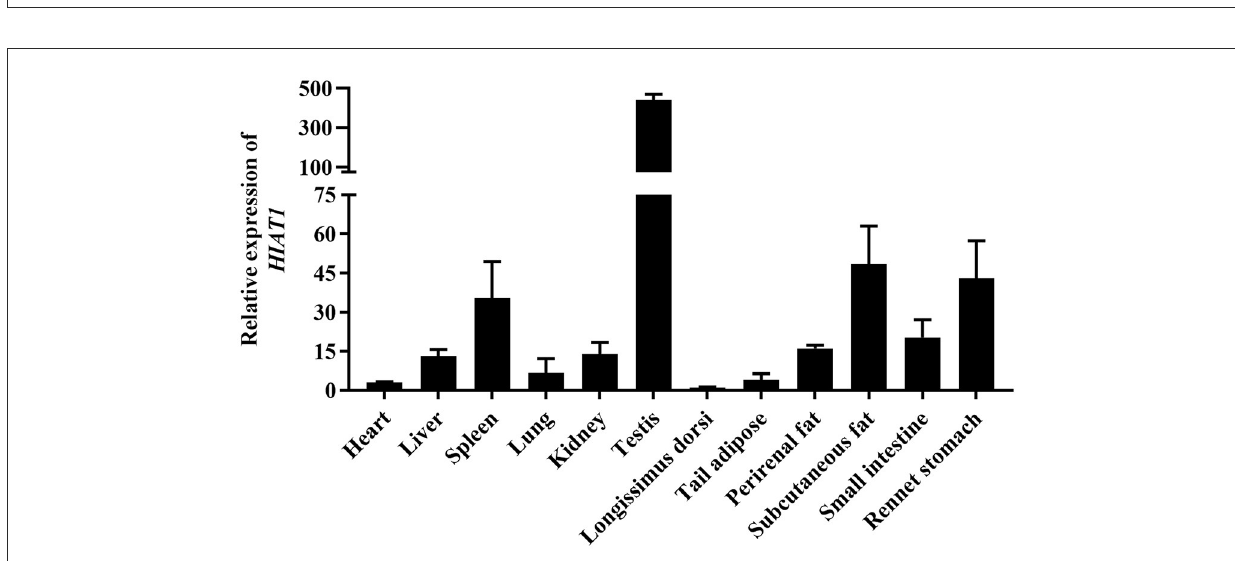
FIGURE2 HIAT1 mRNA expression patterns detected by qPCR in Lanzhou fat-tailed sheep.